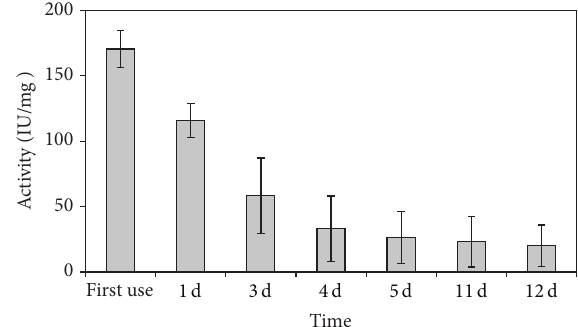
Figure 3: Reusability test for CPO sol-gel beads loaded with 4 𝜇 g/mL CPO. Three sets, each with three beads per tube, were used in this test. The column heights represent the mean specific activity value and the error bars represent ± one standard deviation. The first measurement was taken after the beads were aged for one week with daily buffer exchanges. The number of days that passed before the next reuse is listed on the 𝑥